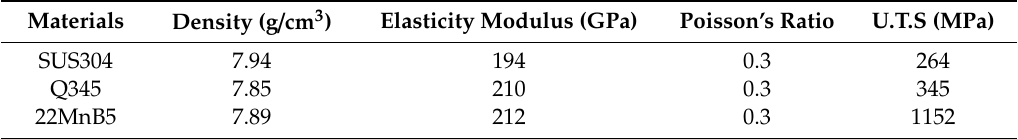
Table 1. Material parameters of the initial seat